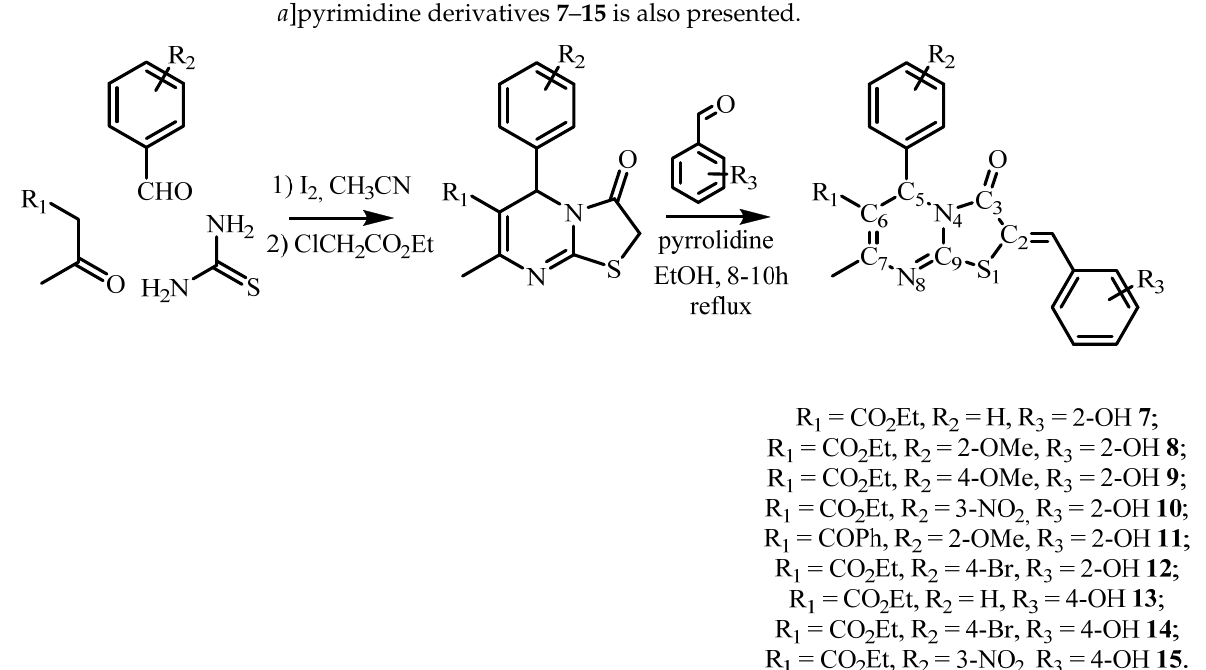
Figure 2. Synthesis of 2 ‐ and 4 ‐ (hydroxybenzylidene)thiazolo[3,2 ‐ a ]pyrimidines 7 – 15 .